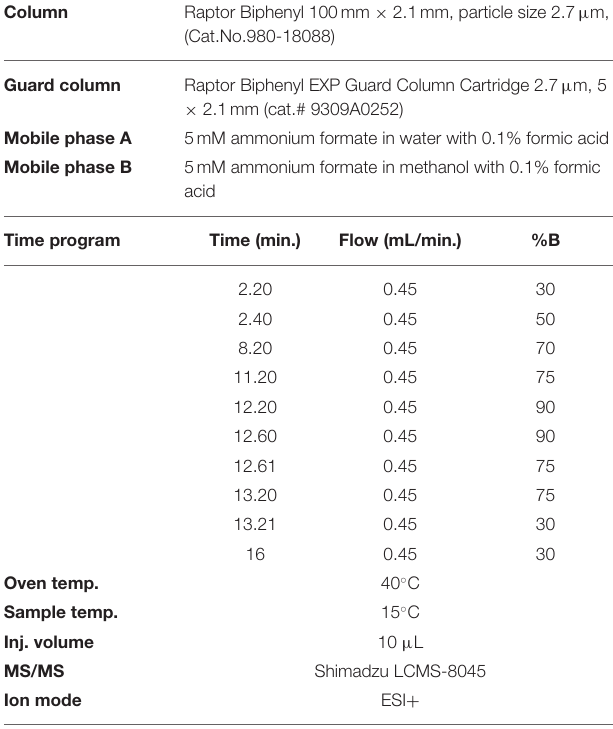
TABLE 1 | Analytical conditions for analysis of aflatoxins and ochratoxin A (gradient method).